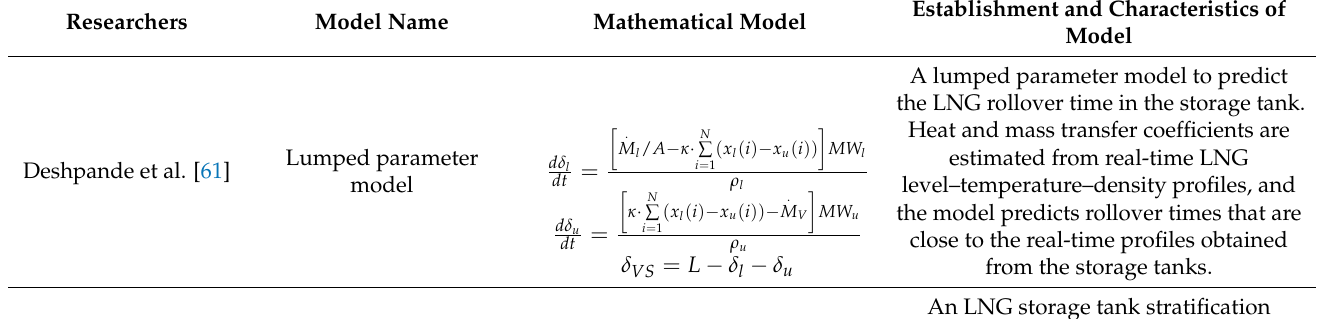
Table 1. Summary of LNG stratification and rollover